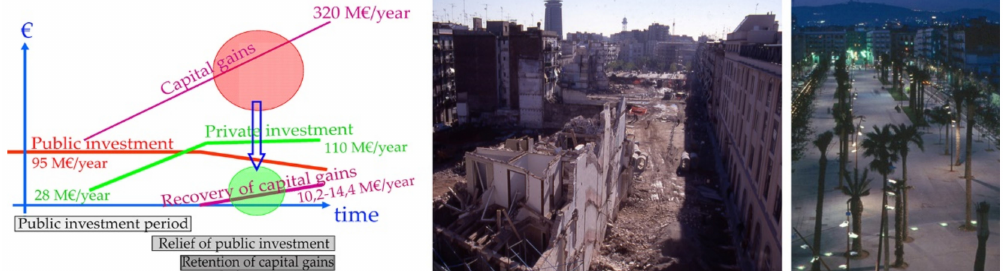
Figure 5. Graph: public investment and capital gains in Ciutat Vella. Images: the opening of the Rambla del Raval in Ciutat Vella, Barcelona. Source of images: opening of the Rambla del Raval. Integrated Rehabilitation Area of Ciutat Vella. Barcelona [43,44].